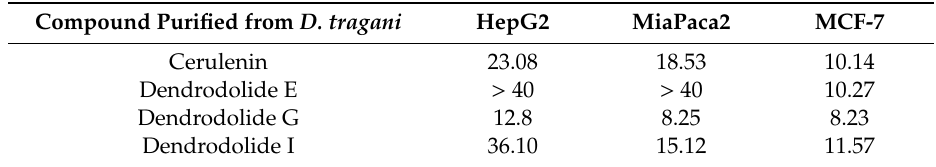
Table 2. ED 50 (µg/mL) of the purified compounds ( 1–4 ) against three different human cancer cell lines Table 2. ED 50 ( µ g / mL) of the purified compounds ( 1–4 ) against three di ff erent human cancer cell lines (HepG2, Miapaca2 and MCF-7). (HepG2, Miapaca2 and